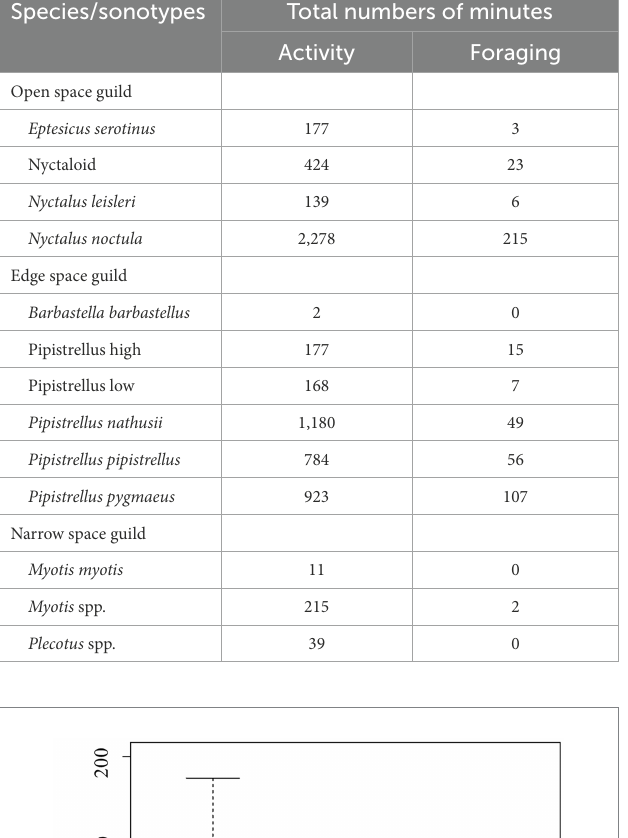
TABLE 2 List of identified species/sonotypes in their associated functional guilds and the accumulated number of activity/foraging minutes based on 47 sampling nights.